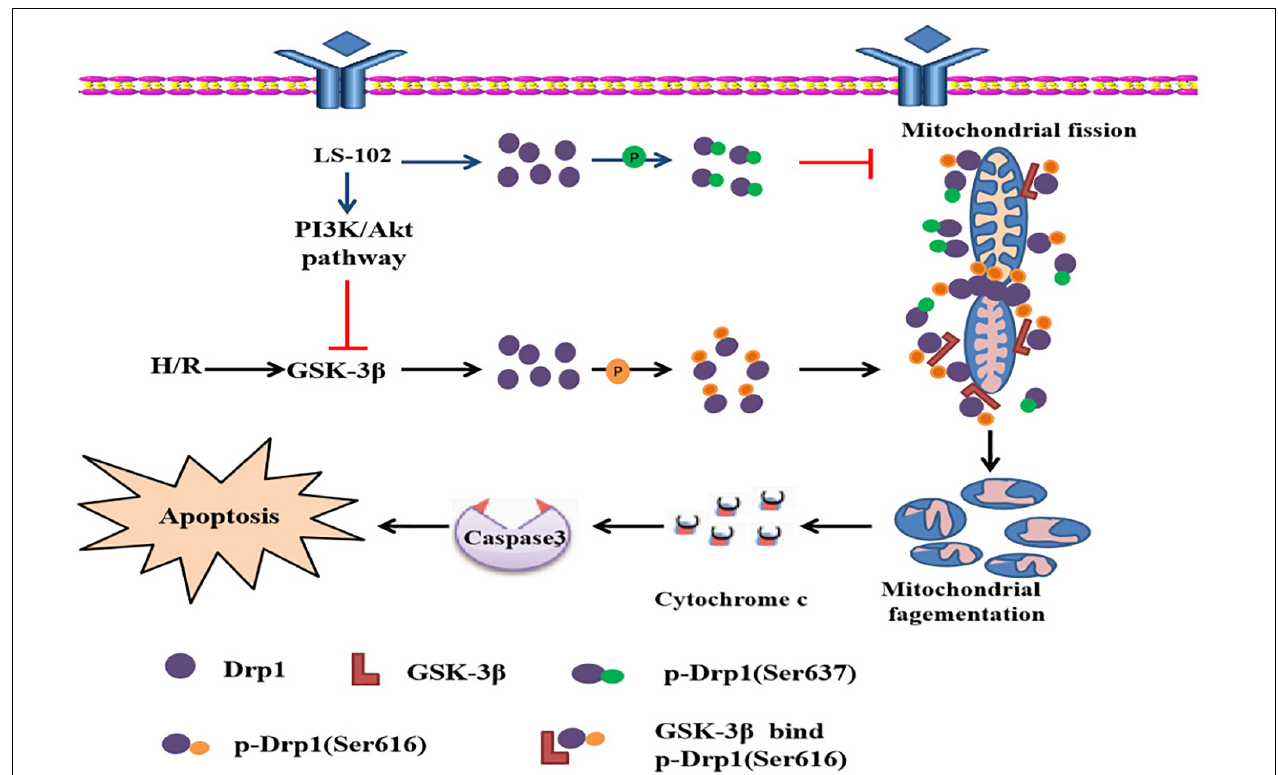
FIGURE 8 | Possiblemechanism of the cardioprotective effect of LS-102 in injury of